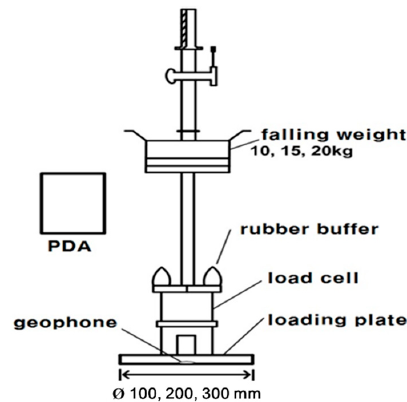
Figure 5. Schematic diagram of the Light Falling Weight Deflectometer (LFWD).